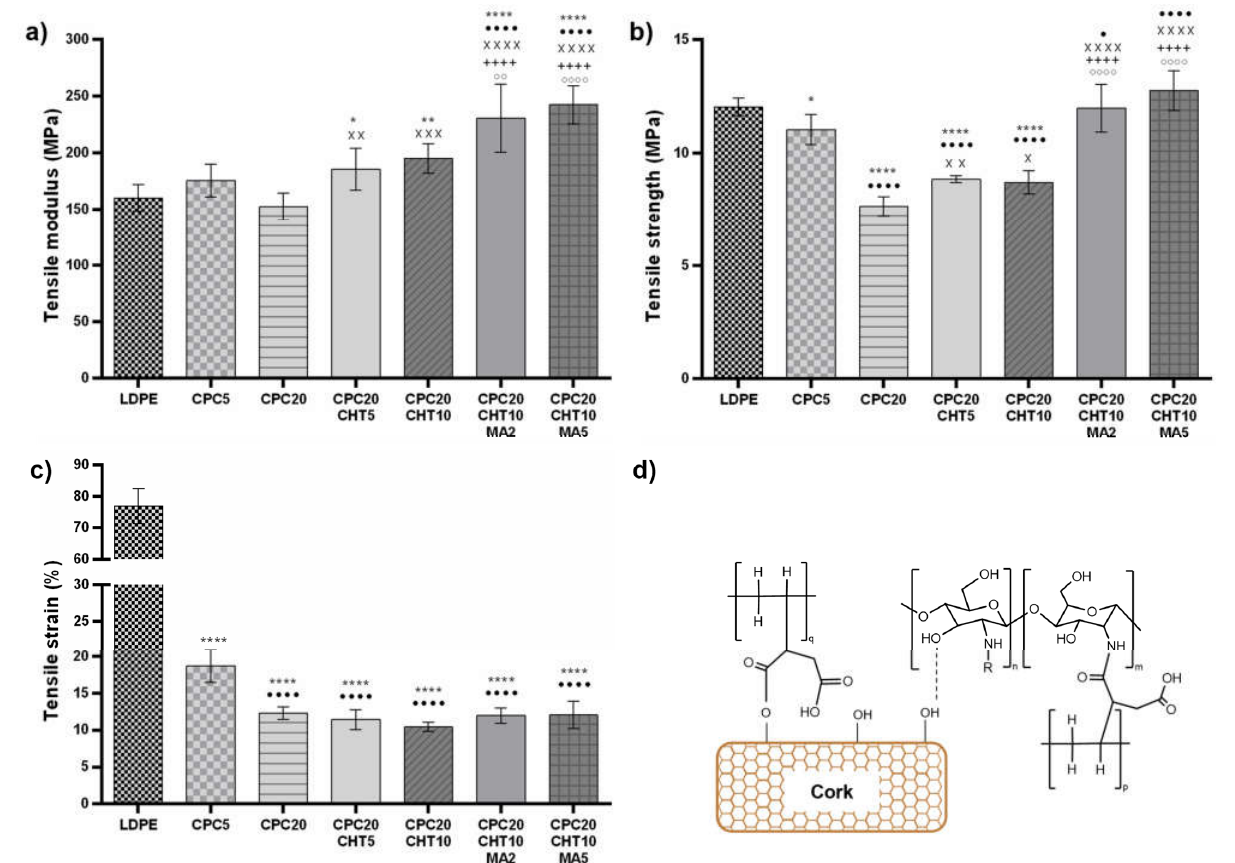
Figure 2. The mechanical properties of the pristine LDPE and the CPC with and without chitosan and the coupling agent PE-g-MA, for the tensile ( a ) elastic modulus, ( b ) maximum strength, and ( c ) strain at maximum load. The significance levels between groups were 1 symbol— p < 0.05, 2 symbols— p < 0.01, 3 symbols— p < 0.001 and 4 symbols— p < 0.0001 related to: * LDPE; • CPC5. x CPC20, + CPC20CHT5, ○ CPC20CHT10; ( d ) scheme of the bounds established between the main components present in the biocomposite.